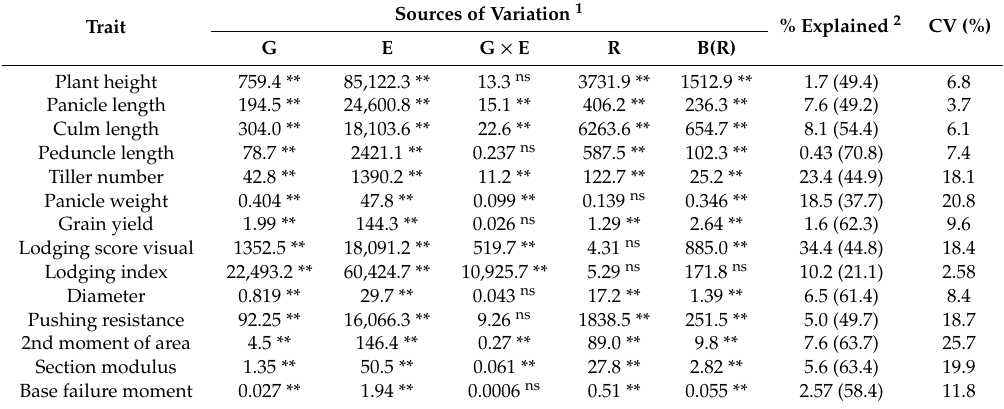
Table 2. Mean squares and statistical significance test of the traits based on combined analysis of variance. Sources of Variation Trait